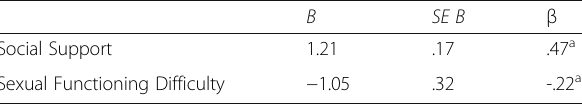
Table 4 Regression Analysis for Marital Satisfaction in